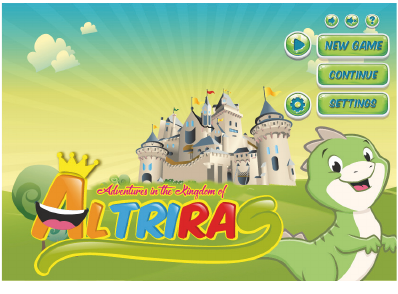
Figure 7: The wizard of emotions explains